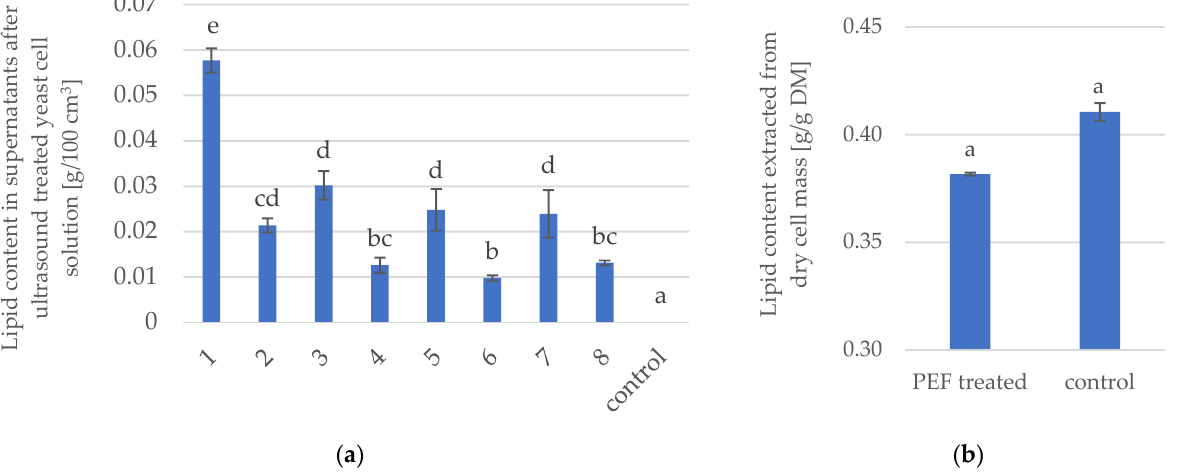
Figure 1. ( a ) Lipid content in supernatants after ultrasound treated yeast cells [g oil/100 cm 3 ]. ( b ) Microbial oil content extracted from dry biomass of PEF-treated Y. lipolytica yeast. Homogeneous groups designated on the basis of Tukey’s test were identified by letters and different posts. Number of treatment refers to individual process parameters according to Table 1 ( a ) or Table 2 ( b ). Control is untreated yeast cells.